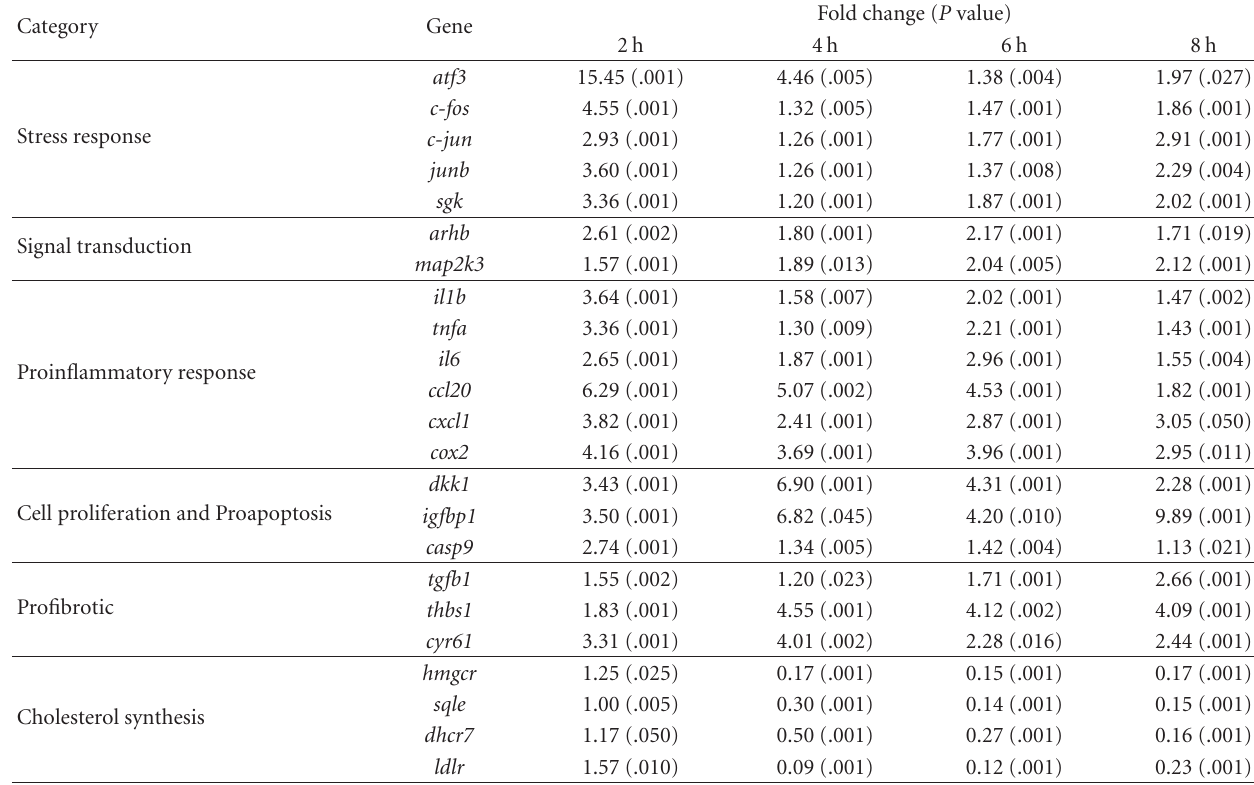
Table 3: Validation of selected genes by